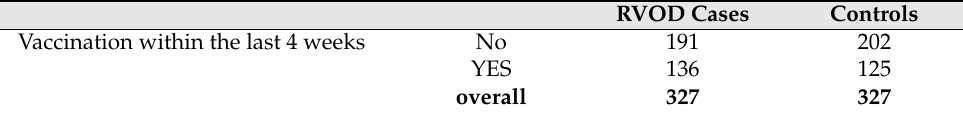
Table 2. Vaccination status within 4 weeks before RVOD symptoms in a 2 × 2 contingency